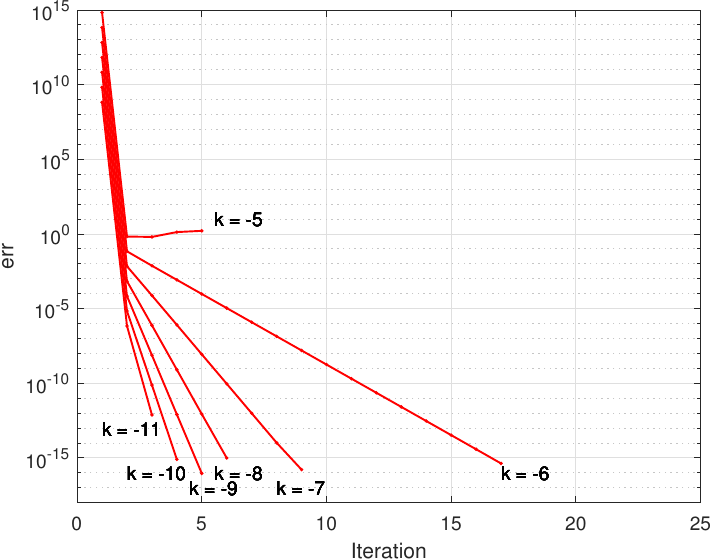
Figure 2. Iterations for determining the global bounds for different